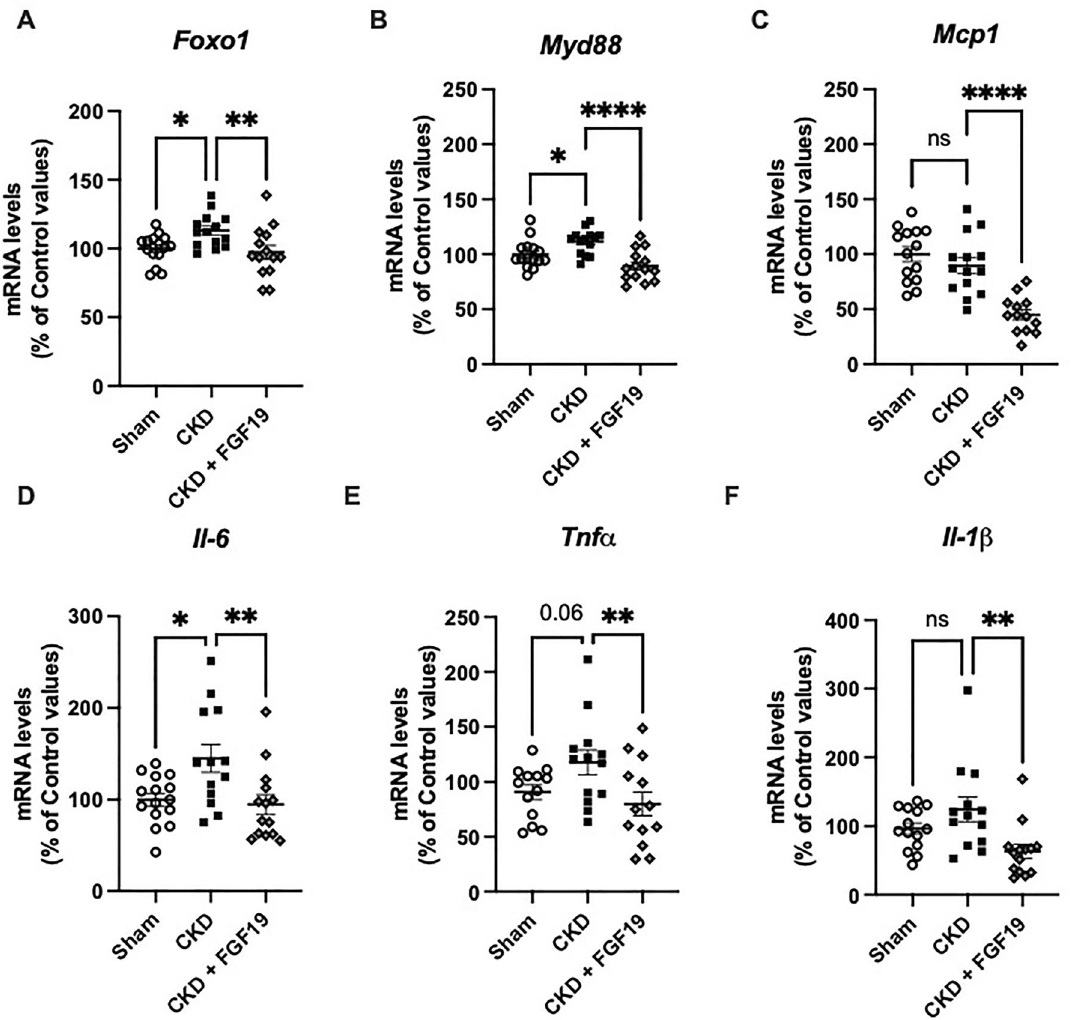
Figure 5. FGF19 reduces hepatic metabolic inflammation in CKD mice. Relative mRNA expression of ( A ) Foxo1 ( B ) Myd88 ( C ) Mcp1 (D) Il-6 ( E ) Tnfα and ( F ) Il-1 β in Sham and CKD mice after FGF19 or vehicle treatment. Tbp (TATA-Box Binding Protein) was used as reference gene to normalize the results. Results are expressed as the ratio of target mRNA levels to housekeeping gene mRNA levels and normalized to the levels in Sham. Data are expressed as mean ± SEM for n = 13–15 animals in each group. Statistical analysis was done using a one-way ANOVA test * p < 0.05, ** p < 0.01, *** p < 0.001. Abbreviation: CKD: chronic kidney disease, Foxo1 : Forkhead box protein O1, Il: interleukine Mcp1 : monocyte chemoattractant protein 1, Tnfα : Tumor Necrosis Factor alpha, n.s., not